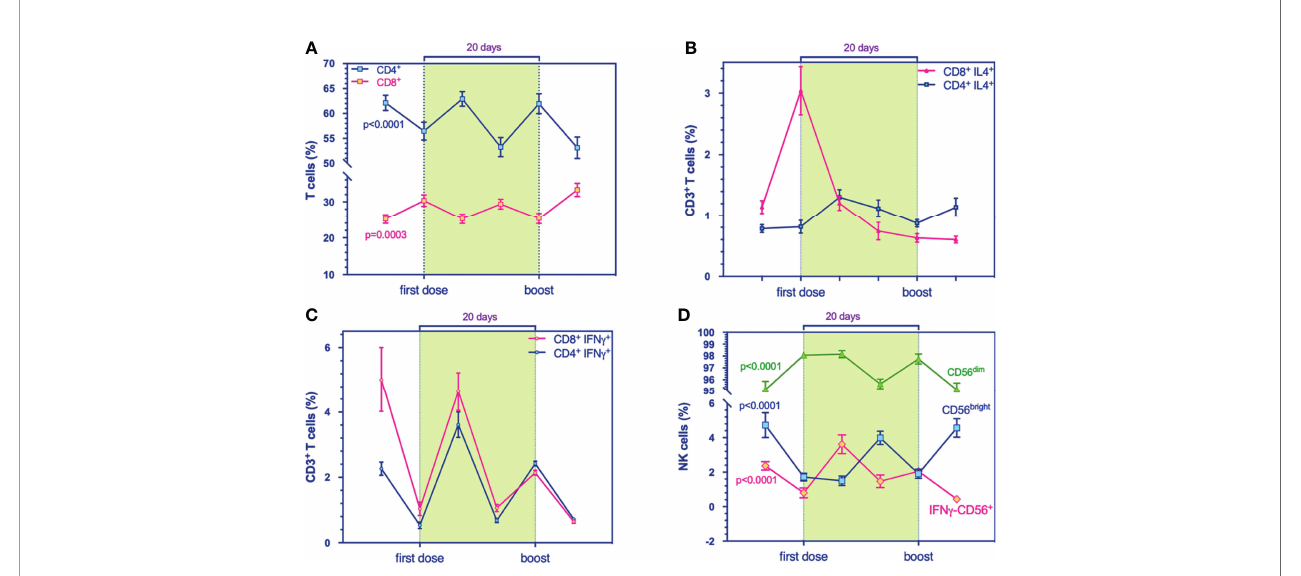
FIGURE 2 | Flow cytometry analysis for immune cell compartments panel. (A) Prevalence % of CD4 + (blue, p < 0.0001) and CD8 + T cells (purple, p = 0.0003). (B) Prevalence % of IL4 + -producing-CD4 + (blue) and -CD8 + T cells (purple), respectively. (C) Prevalence % of IFN g + -producing-CD4 + (blue) and -CD8 + T cells (purple), respectively. (D) Prevalence % of IFN g + -producing NK cells (purple, p < 0.0001), CD56 dim (green, p < 0.0001), and CD56 bright (blue, p < 0.0001) during the timing. Multivariable mixed models for repeated measures adjusted for confounders (time, age, sex, responders) were